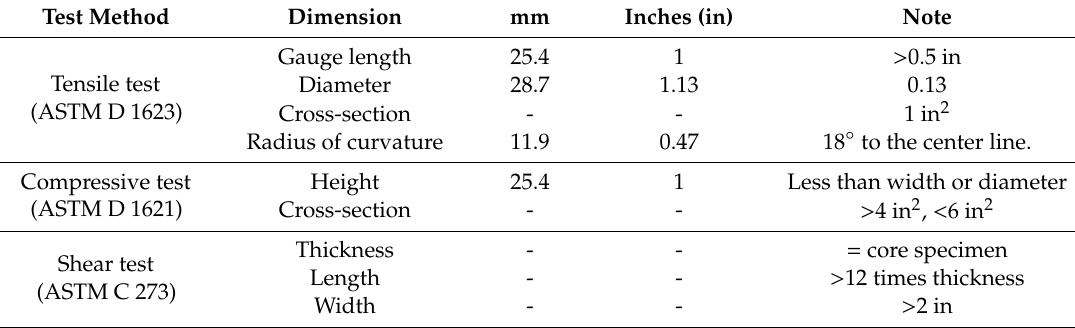
Figure 2. Evaluation of the mechanical performance of rigid PUF according to international standards: ( a ) tensile, ( b ) compression, and ( c ) shear test methods. Table 1. Dimensions of the test specimen according to the evaluation method of mechanical performance of rigid polyurethane foam (PUF).